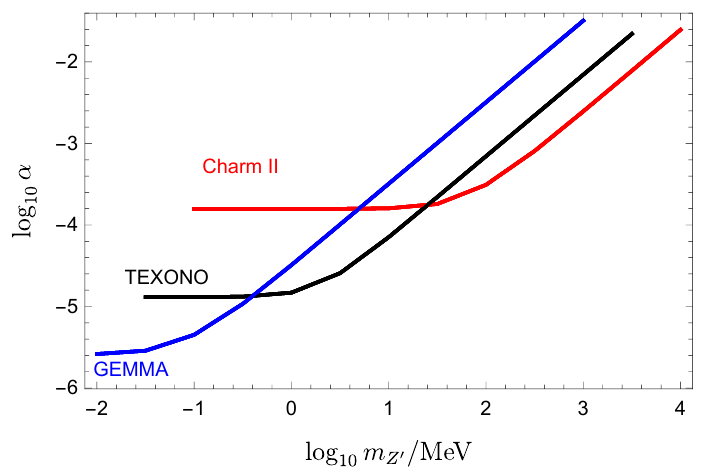
Figure 4 . Constraints on (cid:11) when g X = (cid:15) = 0. The result in this case is independent of the U(1) X charge